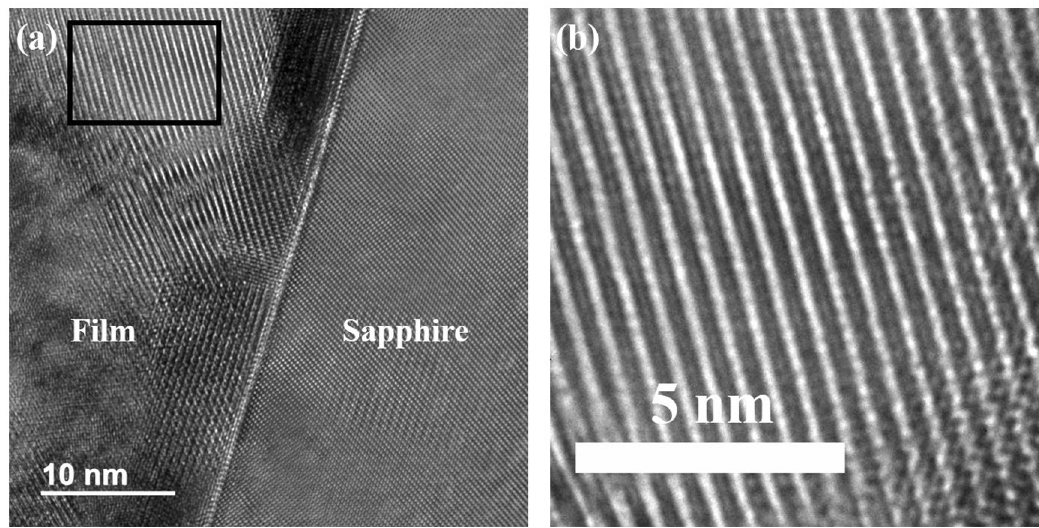
Figure 2. (a) Cross-sectional transmission electron micrograph at the interface of CCO 8000 film and substrate. The magnification of the marked area in (a) is shown in (b), where sublattice layers stacked alternately along c -axis can clearly be seen.